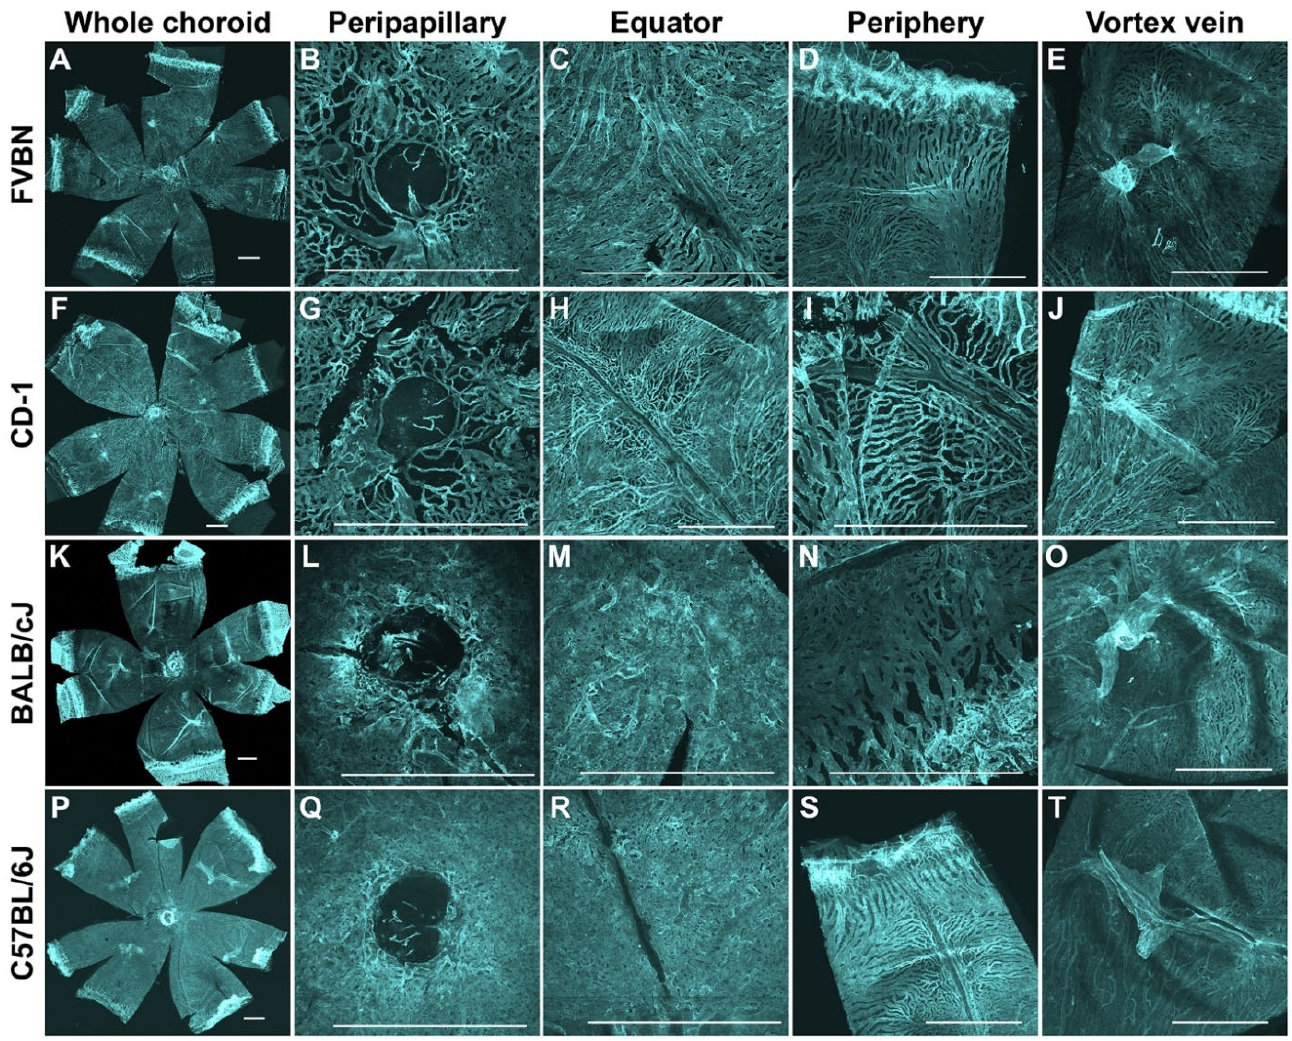
Figure 4. Visualization of the choroidal vasculature from albino and pigmented mice. Representative images from FVBN ( A – E ), CD ‐ 1 ( F – J ), BALB/cJ ( K – O ), and bleached C57BL/6J ( P – T ) mice. Shown are representative images from the low magnification of the whole choroidal vasculature, along with high magnification from the peripapillary, equator, periphery, and vortex vein. The choriocapillaris displays three different patterns, including finger ‐ like projections, honeycomb ‐ like, and maze ‐ like patterns. Images show that the choroids from FVBN and CD ‐ 1 albino mice are sparse and less dense as compared with choroids from BALB/cJ albino mice. Choriocapillaris of the C57BL/6J mice is similar to that in the BALB/cJ mice, but slightly denser. Tissues were stained using an anti ‐ podocalyxin antibody. Number of choroids examined = 14 (FVBN), 7 (CD ‐ 1), 9 (BALB/cJ), and 9 (C57BL/6J). All representative images were from 6 ‐ week ‐ old animals and captured using a confocal microscope. Scale bars: 500 μ m.